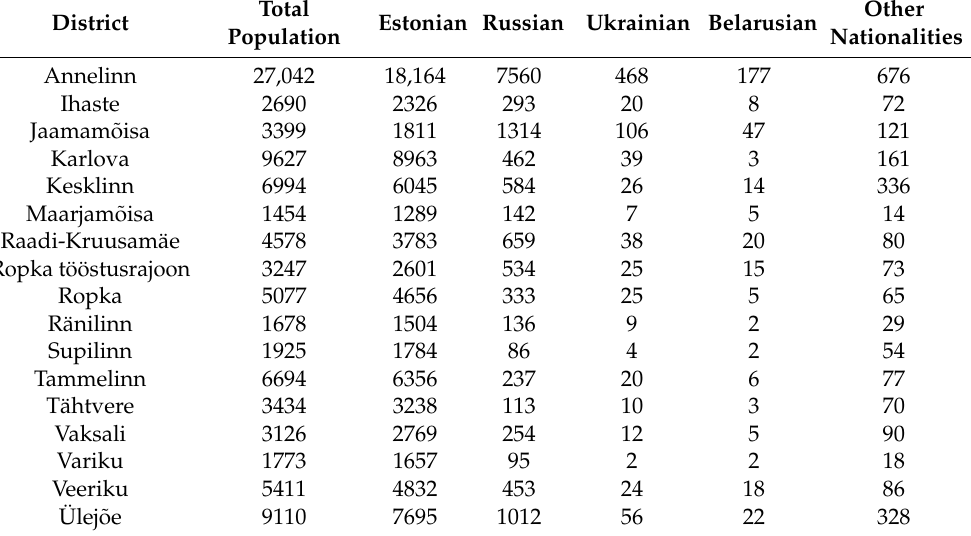
Table 2. Residents per ethnic nationality in Tartu districts. Source: Census, 2011.